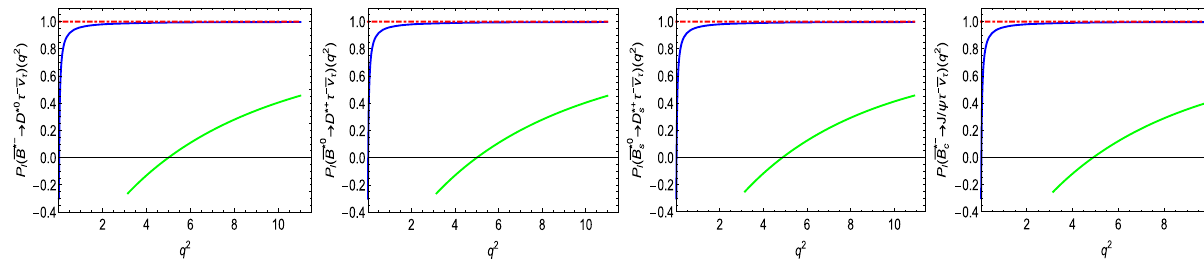
Fig. 3 The lepton polarization fraction P l ( q 2 ) as a function of q 2 for ¯ B ∗ → Vl − ¯ ν l in the SM